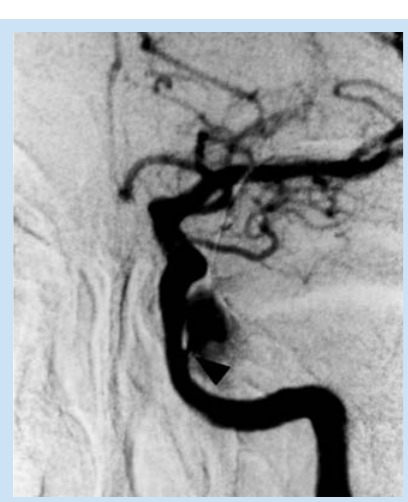
Fig. 1b. Frontal left internal carotid angiogram showing unusually well demonstrated fistula site (arrow).